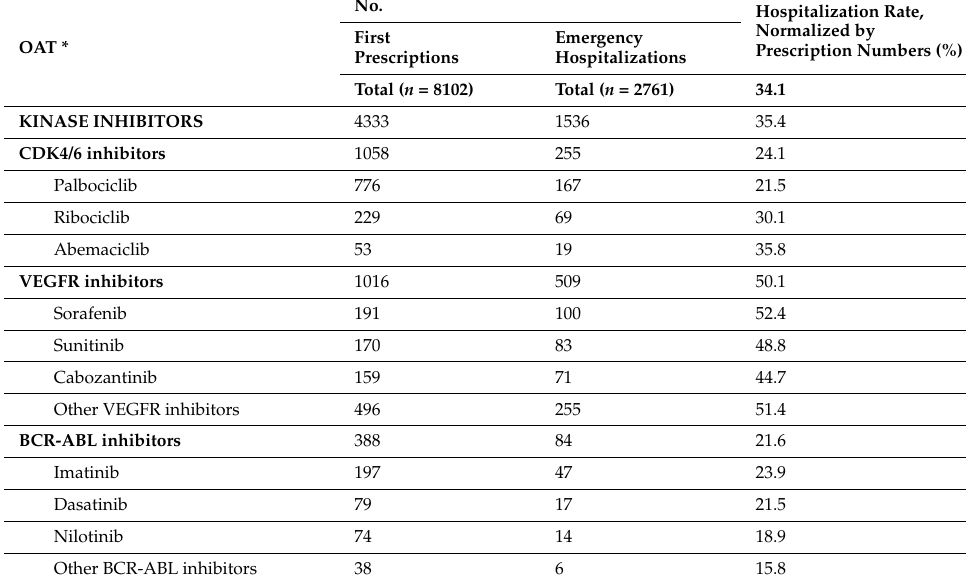
new oral anticancer drugs within the SHI collective of AOK